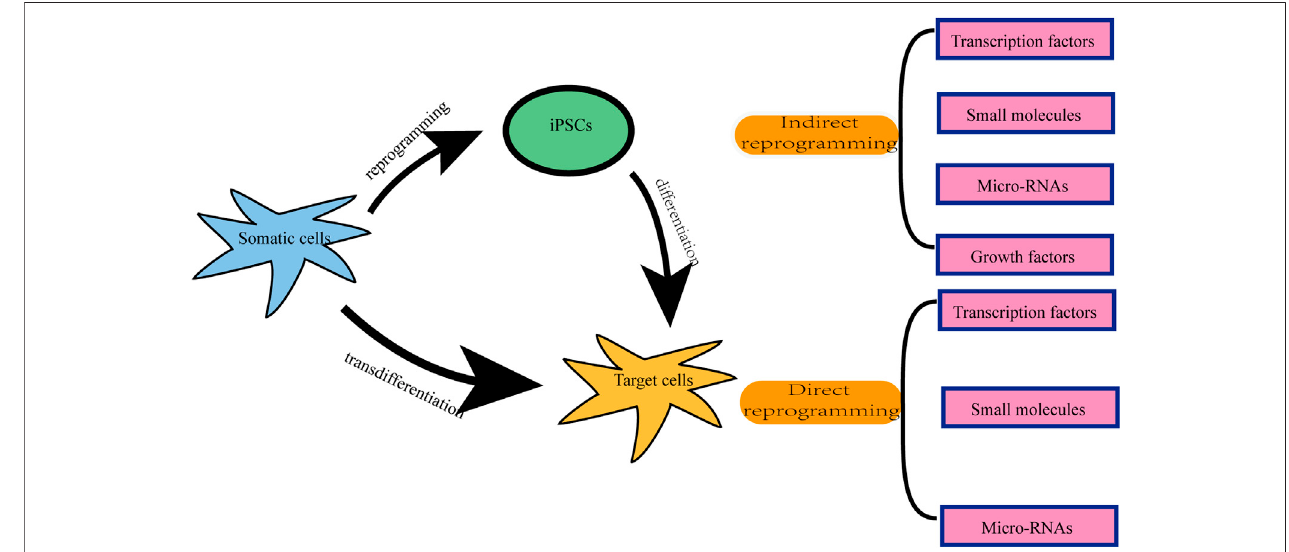
FIGURE 1 | Schematic diagram of two types of reprogramming. iPSCs: induced pluripotent stem cells.